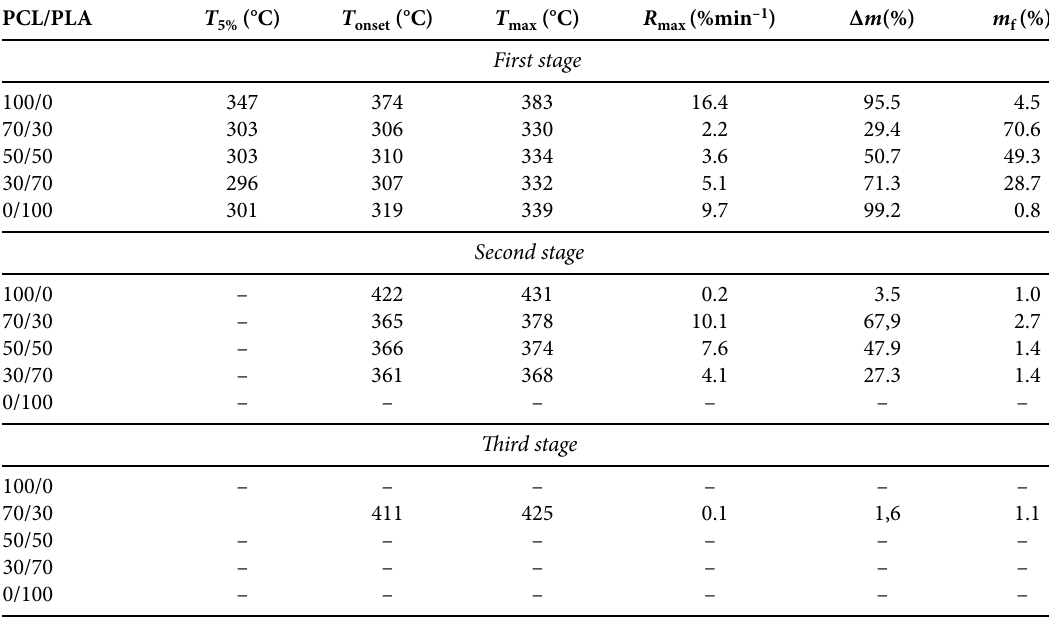
Table 1. The characteristics of thermal degradation curves of PCL/PLA blends (heating rate 2.5 °C min –1 )